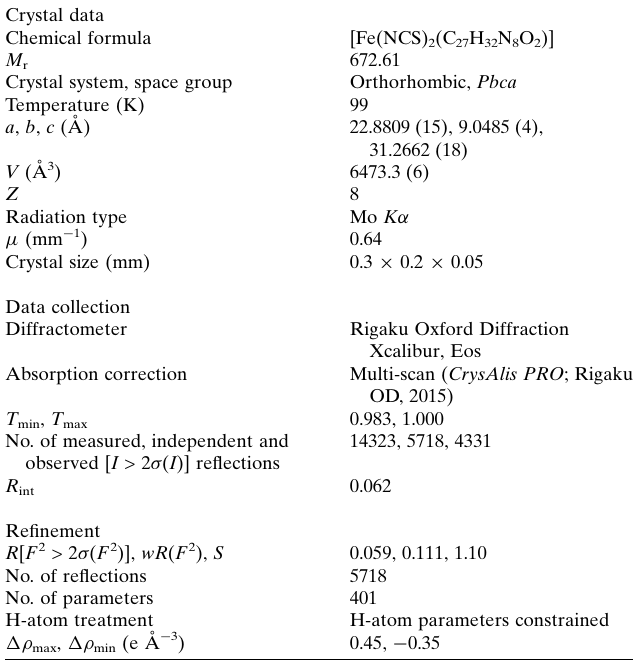
Table 3 Experimental details.